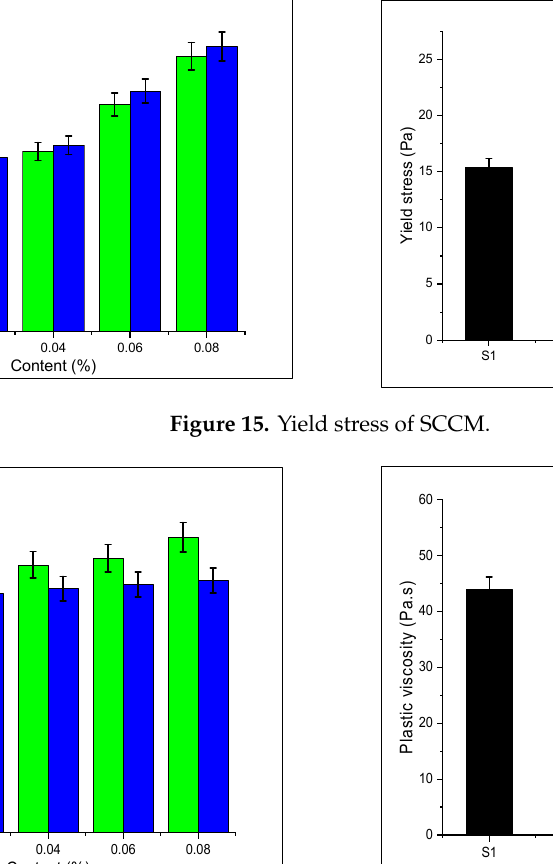
Figure 16. Viscosity of